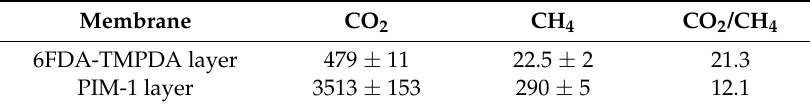
Table 11. Calculated permeabilities (barrer) through composite membranes’ 6FDA-TMPDA and PIM-1